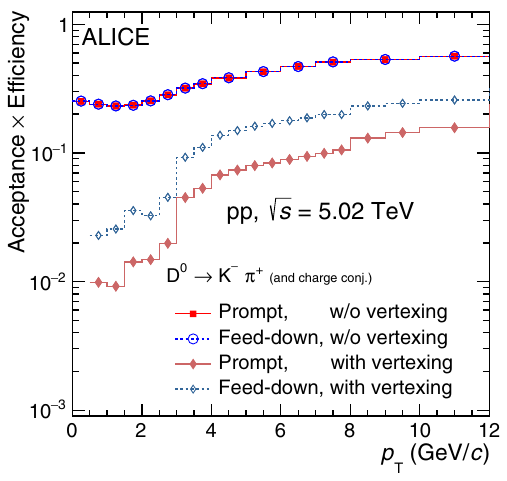
Fig. 4 Product of acceptance and efficiency of D 0 → K − π + (and charge